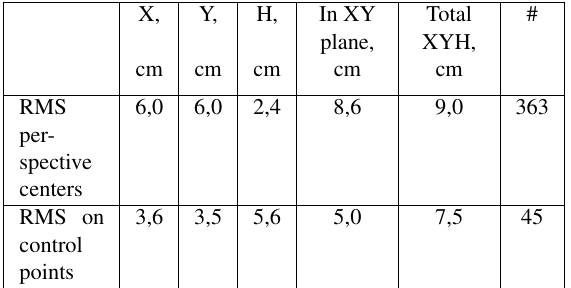
Table 1. Results of aerial triangulation block adjustment with